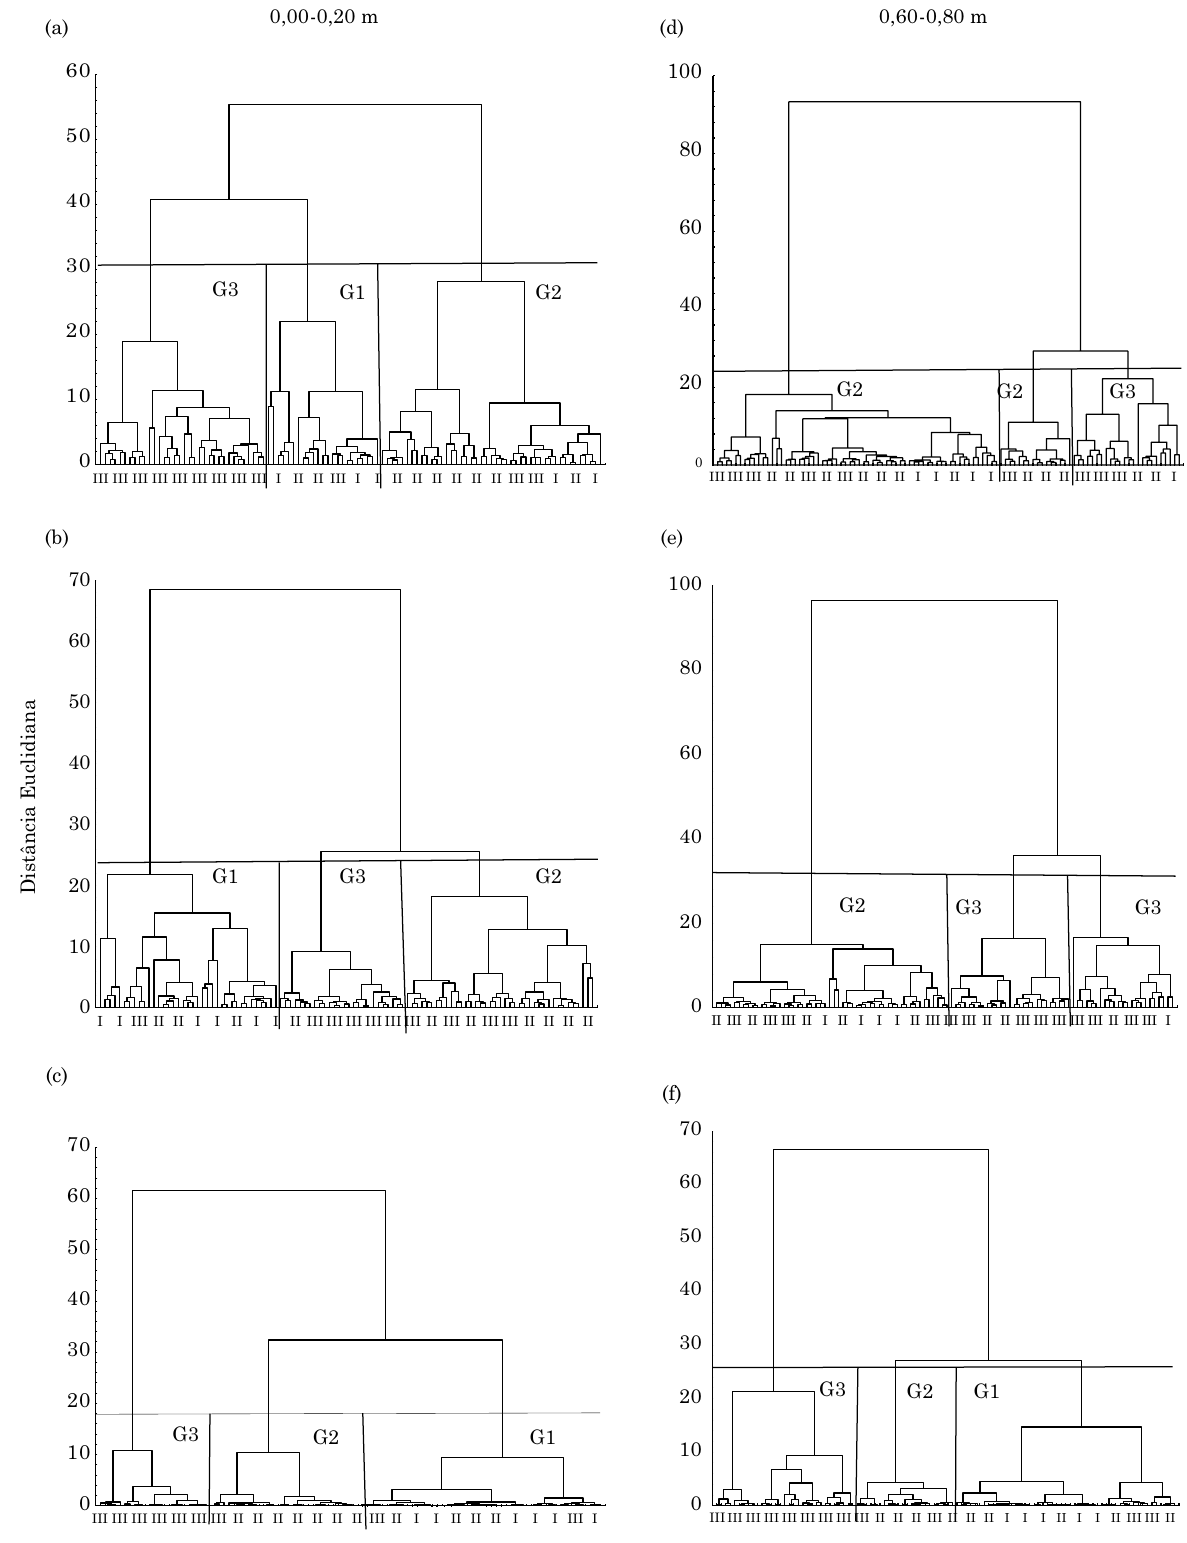
Figura 4. Análise de agrupamento (dendograma) dos atributos químicos, granulométricos e sua relação com a suscetibilidade magnética (SM) em duas profundidades (0,00-0,20 e 0,60-0,80 m), em uma transeção, na separação das superfícies geomórficas. Separação das superfícies por meio dos atributos químicos, granulométricos e SM (a, d), químico e SM (b, e) e granulométricos e SM (c,